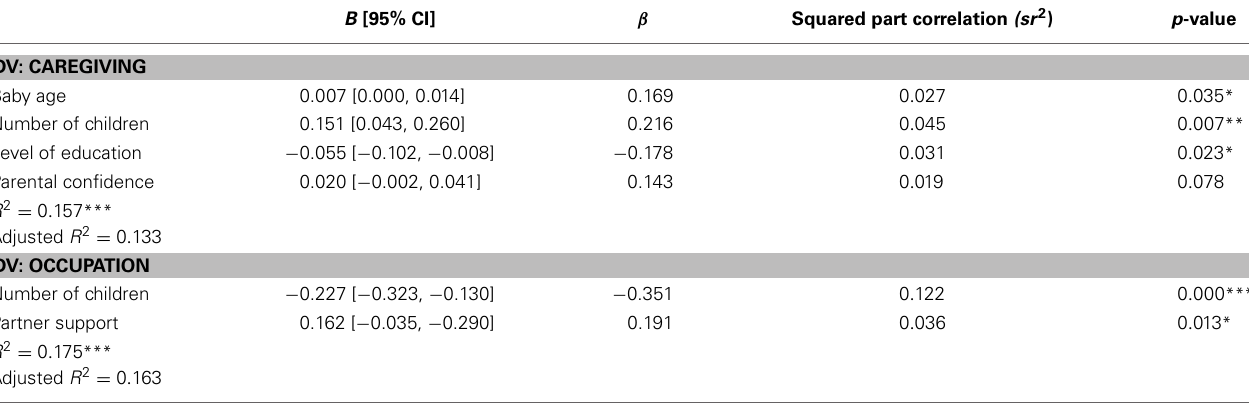
Table 3 | Multiple regression analyses predicting (1) physical activity in the caregiving domain and (2) physical activity in the occupation domain from socio-demographic and parenting variables ( N =